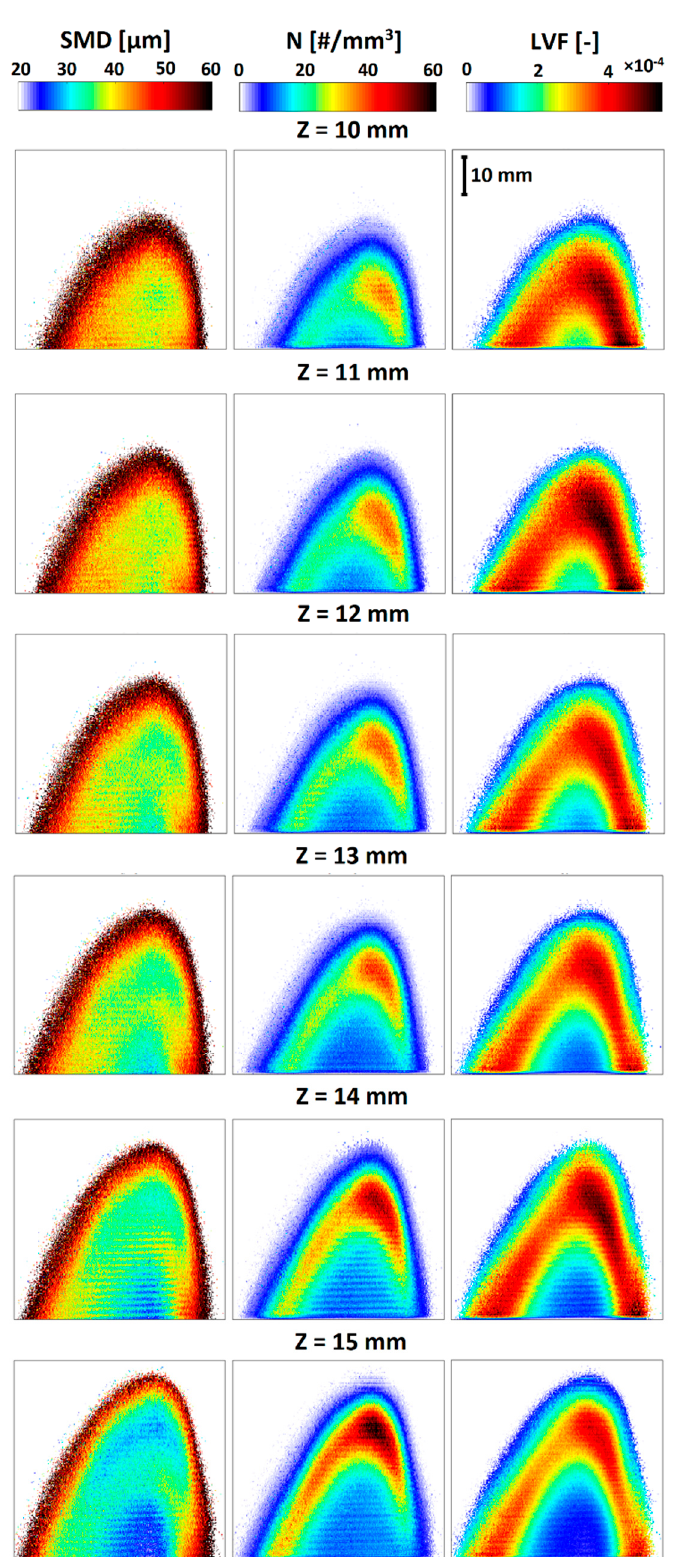
Figure 10. Two-dimensional maps of droplet SMD, N, and LVF, for spray sections at Z = 10, 11, 12, 13, 14, and 15 mm. Droplet SMD varied in the range 20–60 µm. Droplet N varied in the range of 5 to 60 droplets per mm 3 . LVF values from a minimum of 0.1 × 10 − 4 to a maximum value of 5.5 × 10 − 4 .